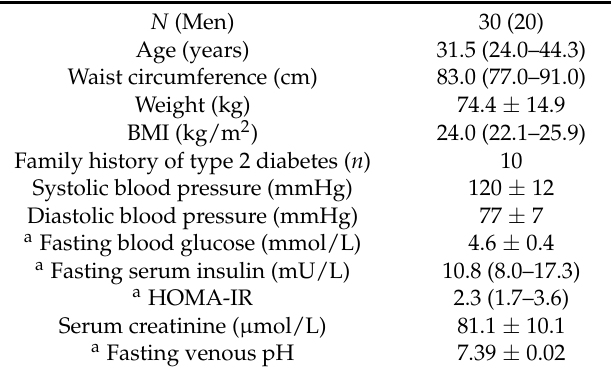
Table 2. Characteristics of the study